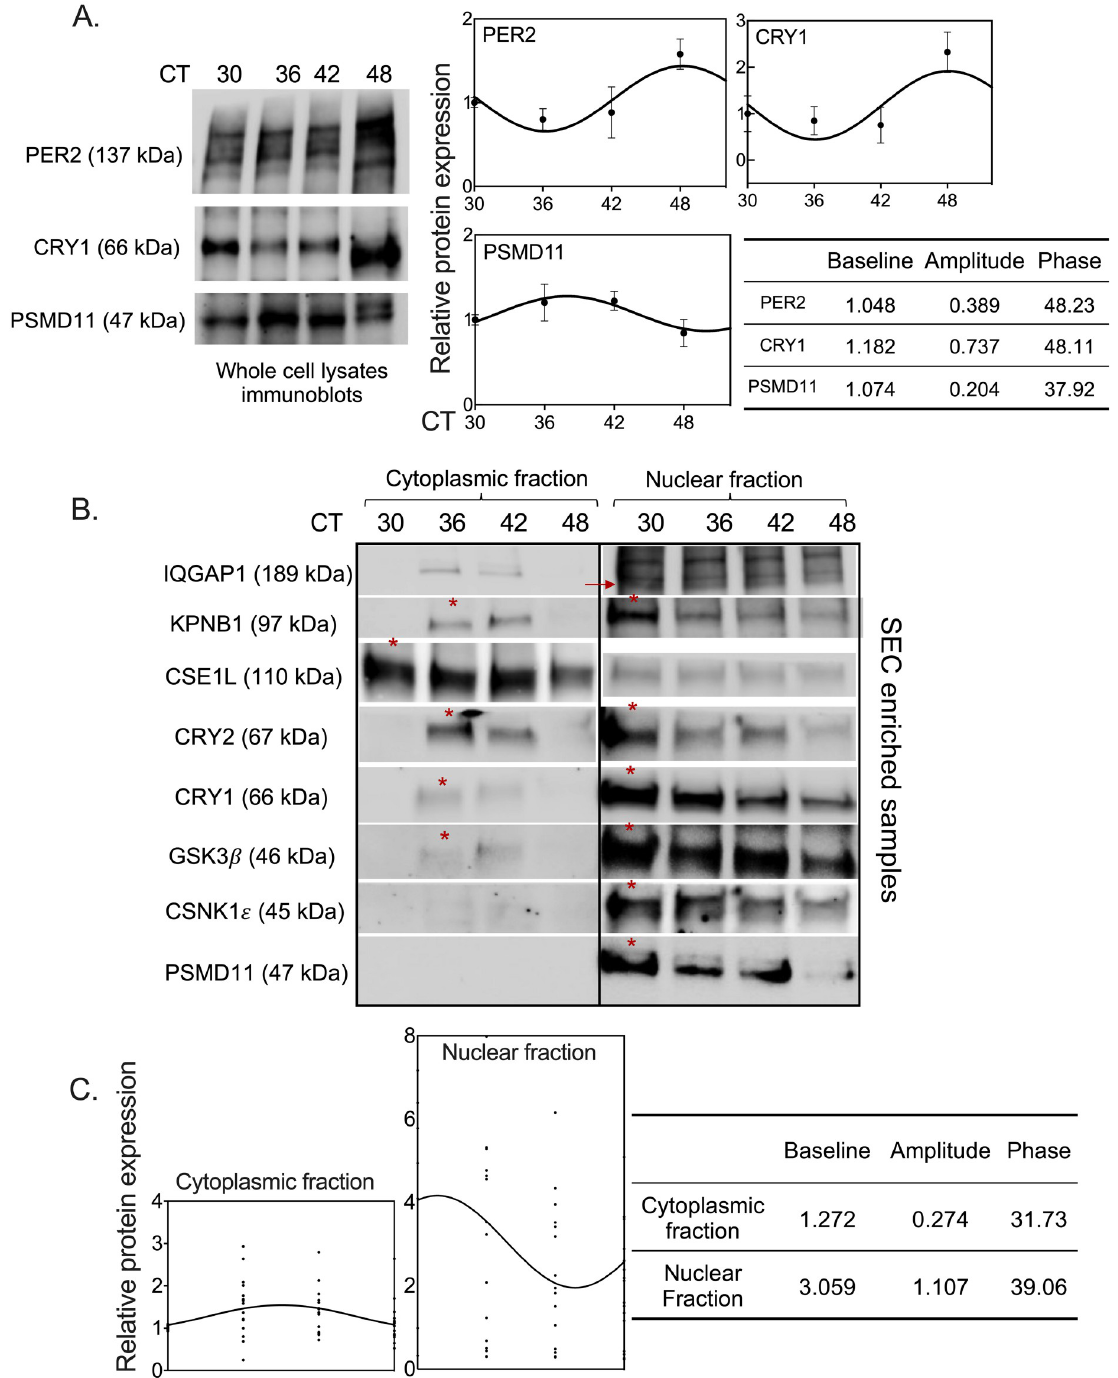
Fig 3. Temporal regulation of NRON complex at cytoplasmic and nuclear fractions. (A) PER2, CRY1 and PSMD11 protein levels in whole cell lysates from CT30, CT36, CT42 and CT48. Multiple bands in PER2 blot are caused by hyperphosphorylated PER2 proteins. Stain-free loading control is represented at S3D Fig. Quantifications of three independent experiments are represented on the right. Baseline, amplitude and phase are calculated with cosinor method. P-values for PER2, CRY1 and PSMD11 respectively; 0.06, 0.08, and 0.11 (B) Spatiotemporal analysis of NRON complex components in U2 OS cells. NRON complex component proteins -IQGAP1, KPNB1, CSE1L, CRY2, CRY1, GSK3 β , CSNK1 ε , and PSMD11- were detected in the fractions 22 to 25 in cytoplasmic and nuclear enriched samples at CT30, CT36, CT42 and CT48 by Western blot. Arrow indicates a non-specific band. Cytoplasmic and nuclear fractions for each protein are run on the same gel. Peak time point of the complex components at each cellular fraction is marked with red asterisks. (C)